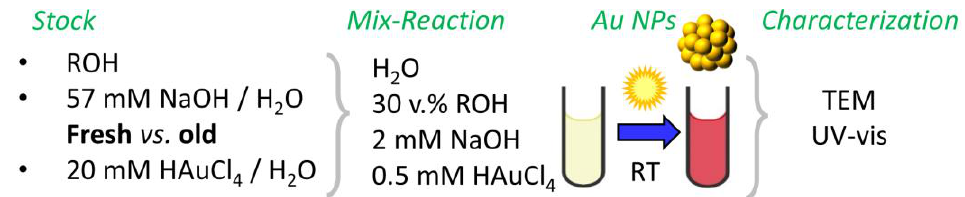
Figure 1. Schematic representation of the surfactant-free RT synthesis investigated here and overview of the present study.